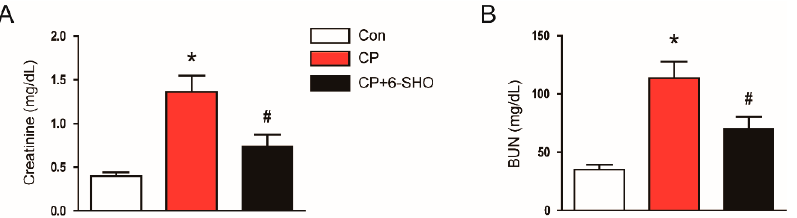
Figure 1. Effect of 6-shogaol on renal function in cisplatin-treated mice. Mice were given an intraperitoneal injection of 6-shogaol (20 mg/kg; 6-SHO) daily for 3 consecutive days, starting from 1 h after cisplatin treatment (20 mg/kg; CP). All mice were sacrificed 72 h after a single dose of cisplatin and blood samples were obtained. ( A ) Serum creatinine levels. ( B ) Blood urea nitrogen (BUN) levels. n = 8 per group of mice. * p < 0.05 versus the control group (Con). # p < 0.05 versus the cisplatin-treated group (CP).